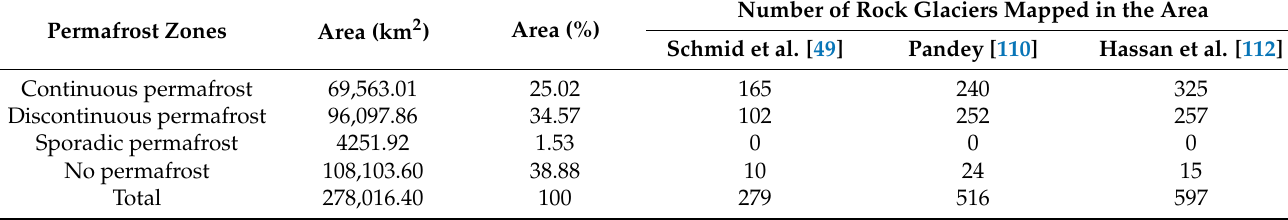
Table 4. The table summarizing the permafrost area in different categories with the number of rock glaciers found in each category which has been considered for accuracy